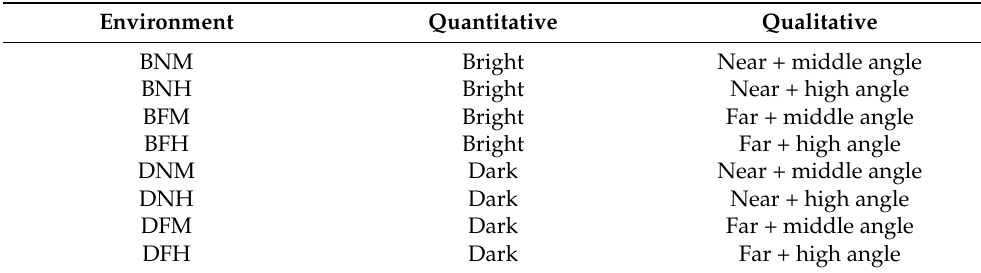
Table 4. Criteria for classification of experimental environment.